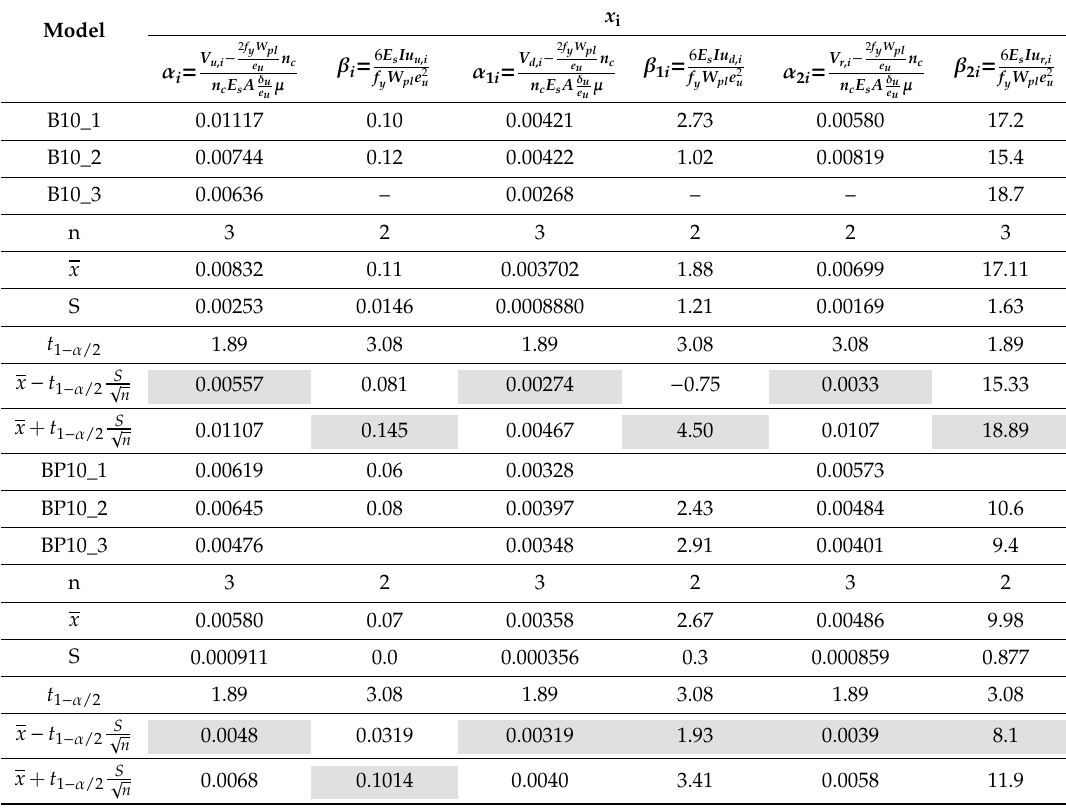
Table 12. Validation of empirical coe ffi cients of the model with reinforced wall joints.